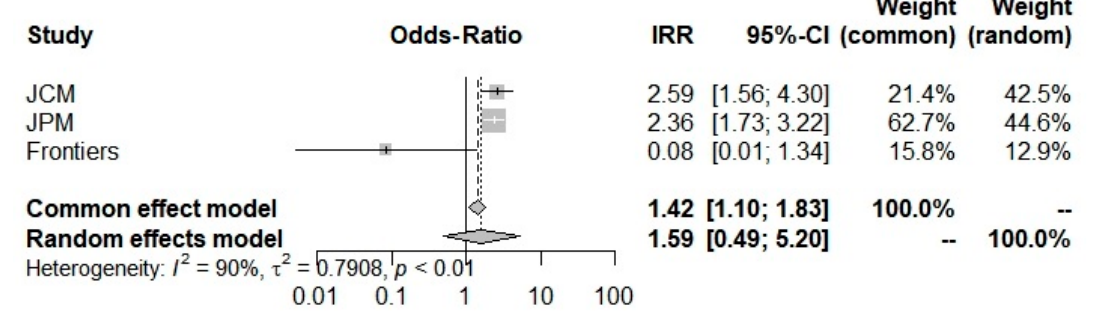
Figure 4. Odd ‐ Ratios of COVID ‐ 19 severity into beta ‐ thalassemia carriers.